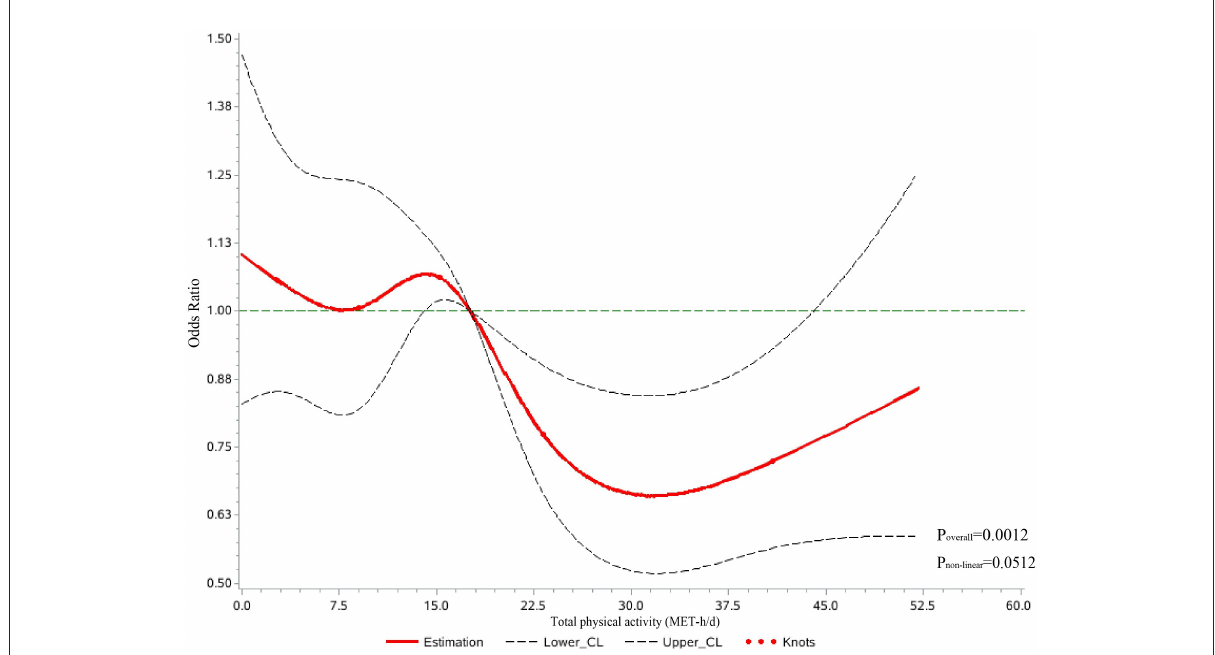
FIGURE2 Dose-response relationship between total physical activity per day and major adverse cardiovascular events in restricted cubic spline among all participants. CL, confidence limit; MET-h/d, metabolic equivalents of task per hour per day. Curves were fitted as a smooth term using a restricted cubic spline with five knots (5th, 25th, 50th, 75th, and 95th). Age in the regression model using an RCS function was treated as a potential confounder, and the mean MET values were treated as reference spots. The model was adjusted for sociodemographic factors